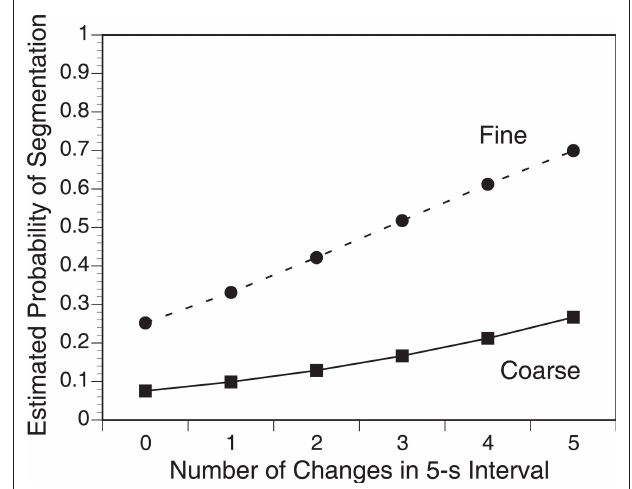
FIGuRE 1 | As the number of situation changes during the movie increased, viewers’ probability of coarse and fine segmentation increased. Estimated probabilities were calculated by fitting logistic regression models for each participant, constructing a model using the mean regression coefficients across participants, and predicting each data point from that model.